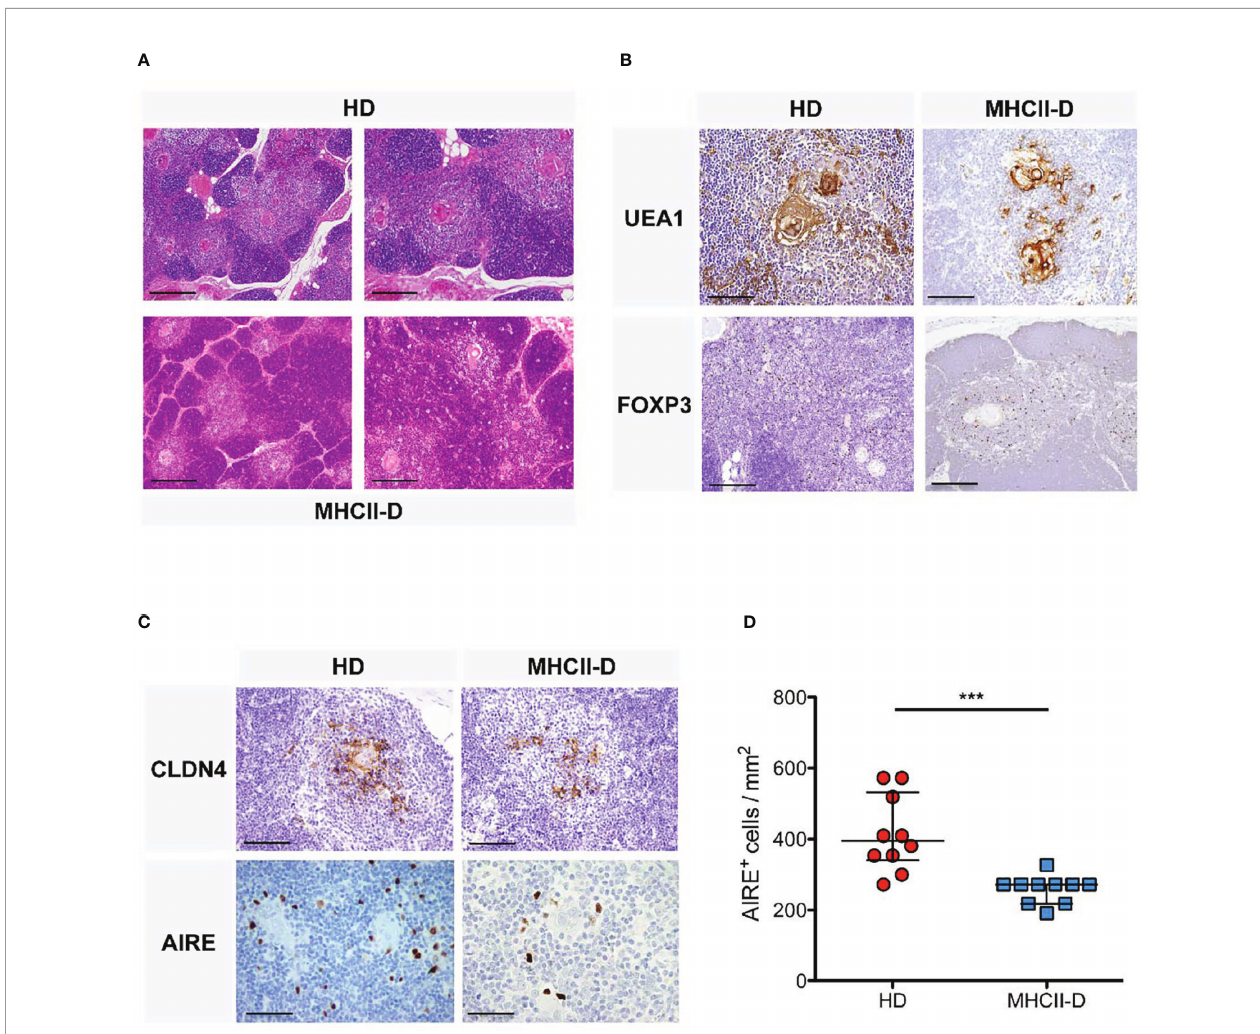
FIGURE 1 | Thymic structure perturbation in a MHCII-D patient ’ s thymus. (A) Histological analysis of a MHCII-D patient ’ s thymus. Immunohistochemistry analysis of thymic tissue isolated from a human healthy donor (HD) and a MHCII-D patient. Hematoxylin – eosin (H&E) staining shows a reduced representation of thymic medulla. Original magni fi cation 4×, corresponding to 500 m m. (B) UEA1 and FOXP3 staining in MHCII-D thymus. Immunohistochemistry analysis of Ulex Europaeus Agglutinin I (UEA1) and FOXP3 expression in a thymic tissue isolated from a human HD and a MHCII-D patient. Original magni fi cations: 20× for UEA1 and 10x for FOXP3 staining images, corresponding respectively to 100 and 200 m m. (C) AIRE and CLDN4 expression in MHCII-D thymus. Immunohistochemistry analysis of CLDN4 (Claudin 4) and AIRE expression in a thymic tissue isolated from a human HD and a MHCII-D patient. Original magni fi cations: 20× for CLDN4 and 40× for AIRE staining images, corresponding respectively to 100 and 50 m m. (D) AIRE expression is reduced in MHCII-D thymus. Comparison of the concentration of AIRE + cells per square millimeter (mm 2 ) in a thymic tissue isolated from a human HD and a MHCII-D patient. Mann – Whitney test, p-value < 0.001. Bars represent median with interquartile range. ***p value <